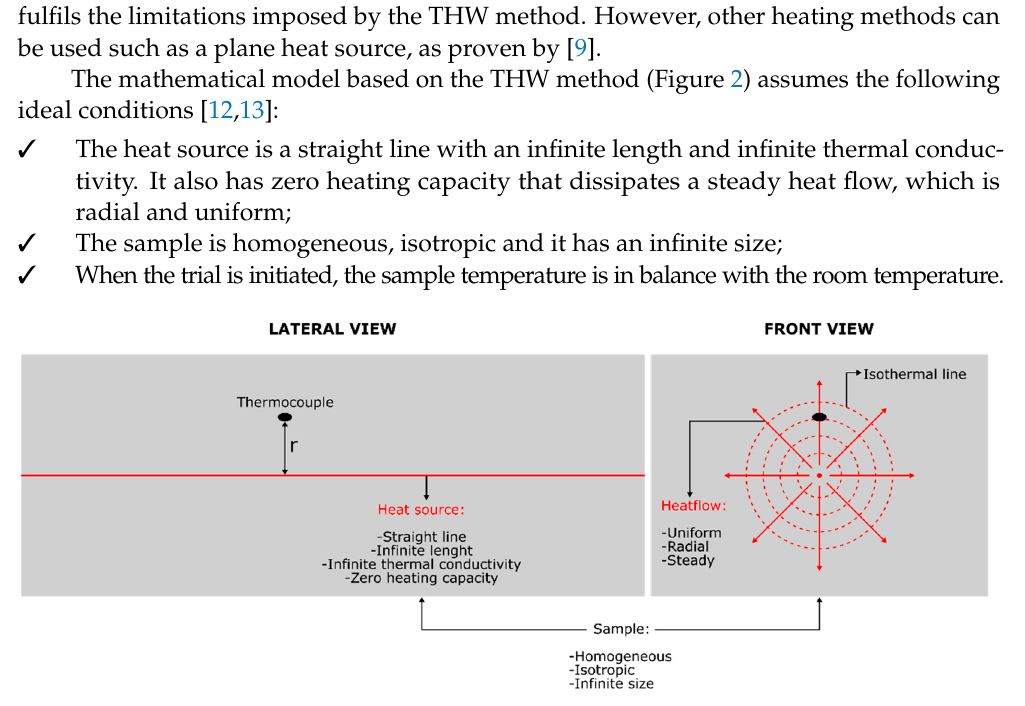
Figure 2. Lateral and frontal sample view in the THW mathematical model.